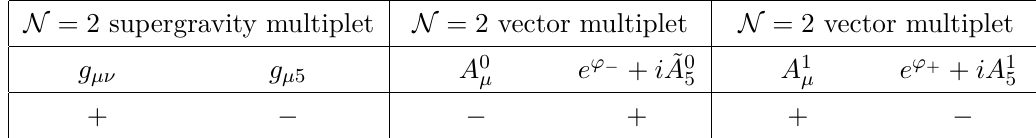
Table 2 . Bosonic content of the D = 4 , N = 2 multiplets and their Z 2